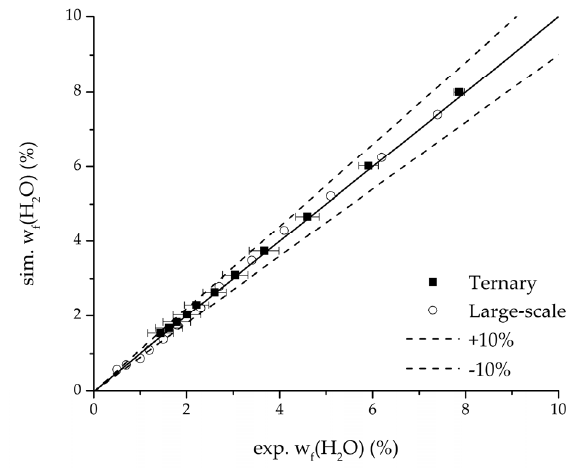
Figure 22. Parity plot between the experimental and simulated water mass fraction (feed) for the ternary system at 95 °C feed temperature.